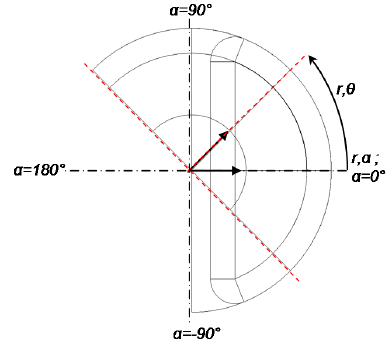
Figure 4. Rotor and stator cylindrical references.